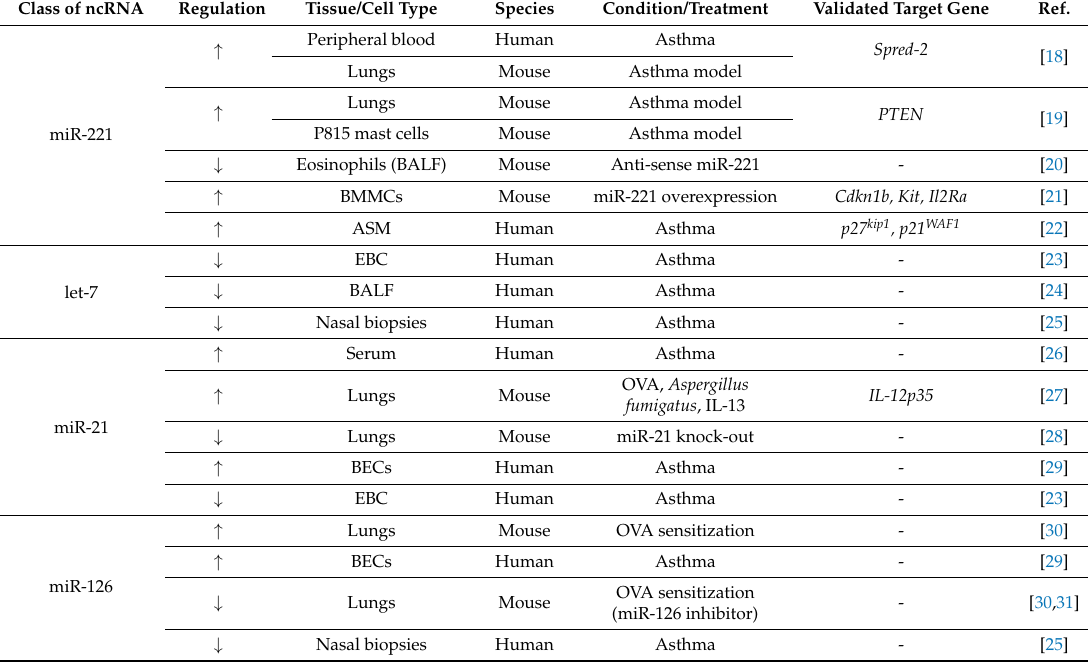
Table 1. Non-coding RNAs (NcRNAs) in clinical and animal models of